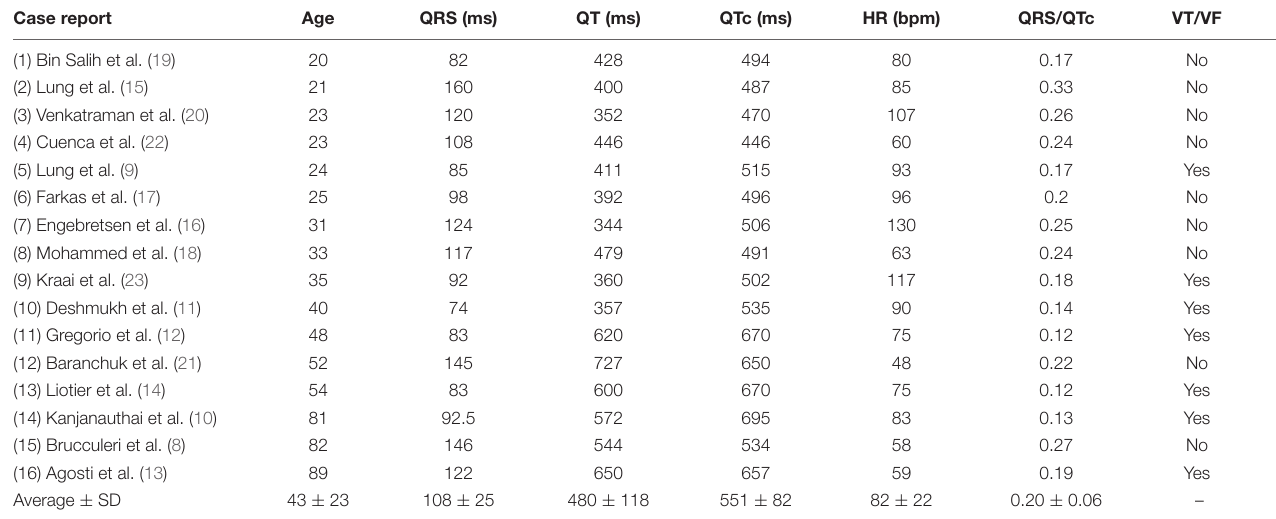
TABLE 2 | ECG-data from the included patients as given in the case-reports or calculated from included ECG-recordings. Case